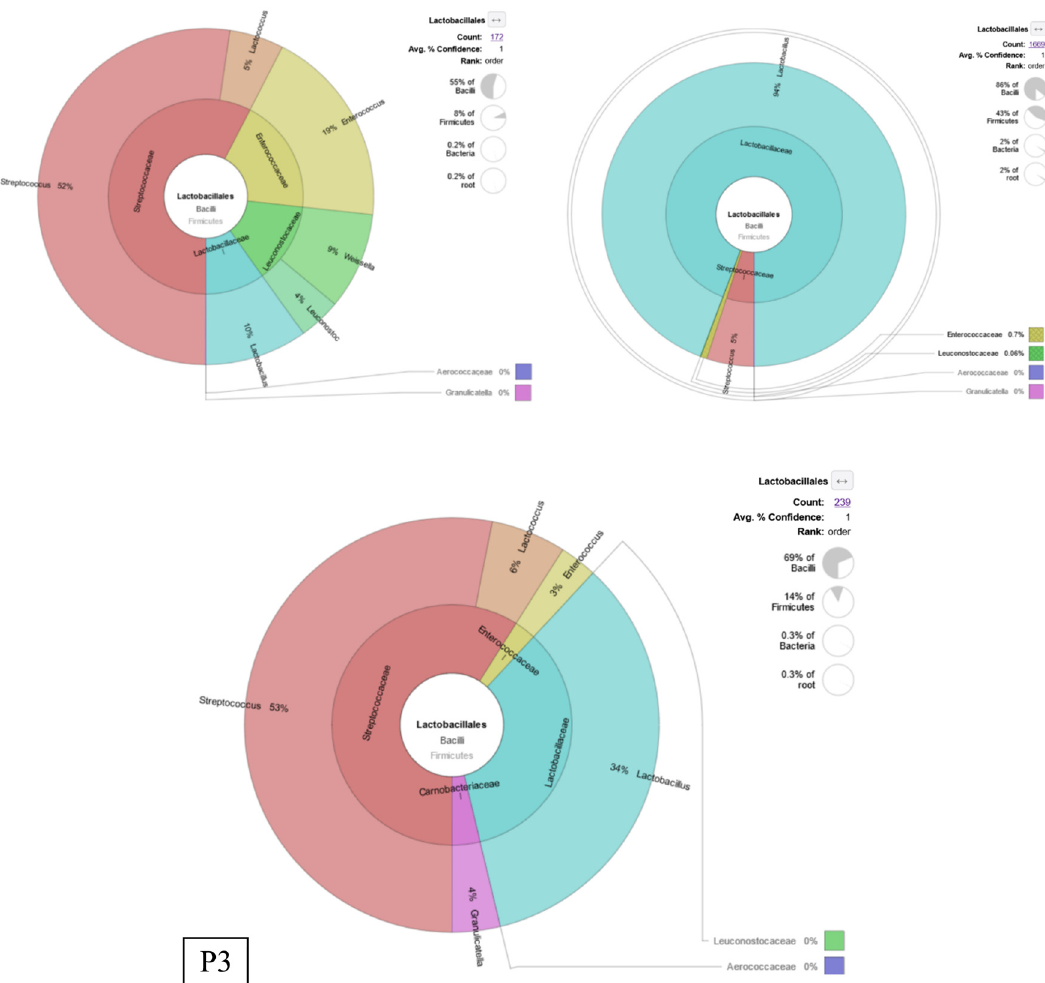
Figure 4: KRONA visually displays the analysis result of taxonomic annotation. Circles from inside to outside stand for di ff erent taxonomic ranks, and the area of the sector means a respective proportion of di ff erent OTU annotation results. Number and proportion of Lactobacillus spp. in the GI tract of white shrimps are depicted in the fi gure. Each fi gure represents sampling locations ( P1 is pond 1, P2 is pond 2, and P3 is pond 3 ) . Each fi gure consists of ten pooled shrimp